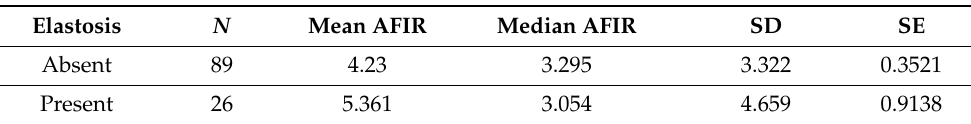
Table 5. Descriptive statistics for the variable “Elastosis”. AFIR: autofluorescence intensity ratio; SD: standard deviation; SE: standard